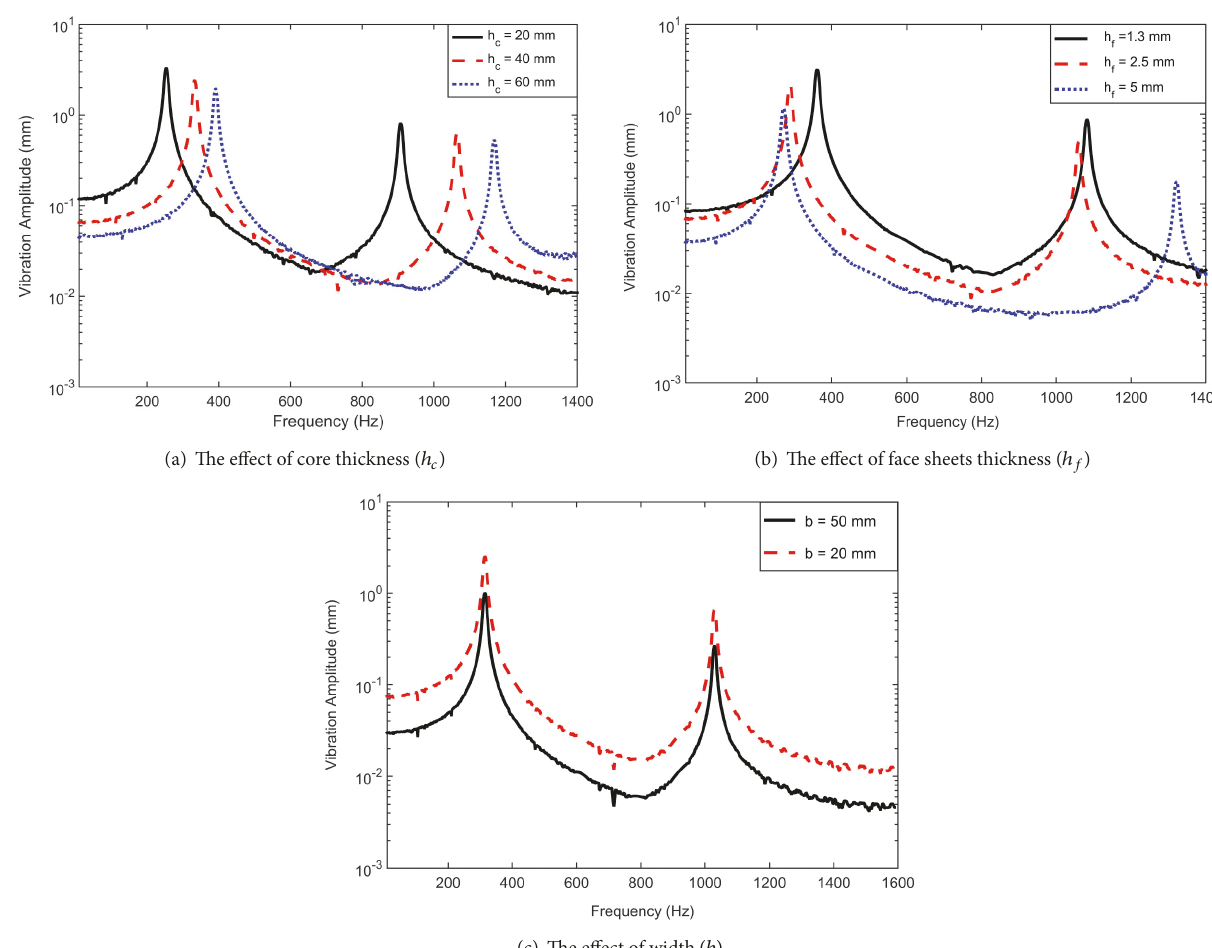
Figure 6: Vibration amplitude at the middle of the simply-simply supported edges sandwich beam with respect to applied frequency. 9 3 2 − ( + ) (𝑤 󸀠 + 𝑤 󸀠 ) − 𝑤 󸀠 ] = 0 10ℎ 10ℎ 5ℎ 𝑓 𝑐 𝑐 𝑡 𝑏 𝑐